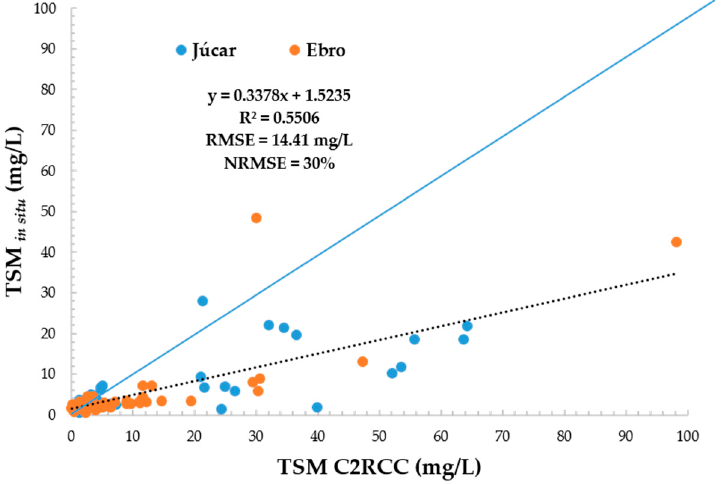
Figure 6. Correlation between TSM measured in the Júcar and Ebro reservoirs and TSM given by the C2RCC processor. In blue, line 1:1 is shown.